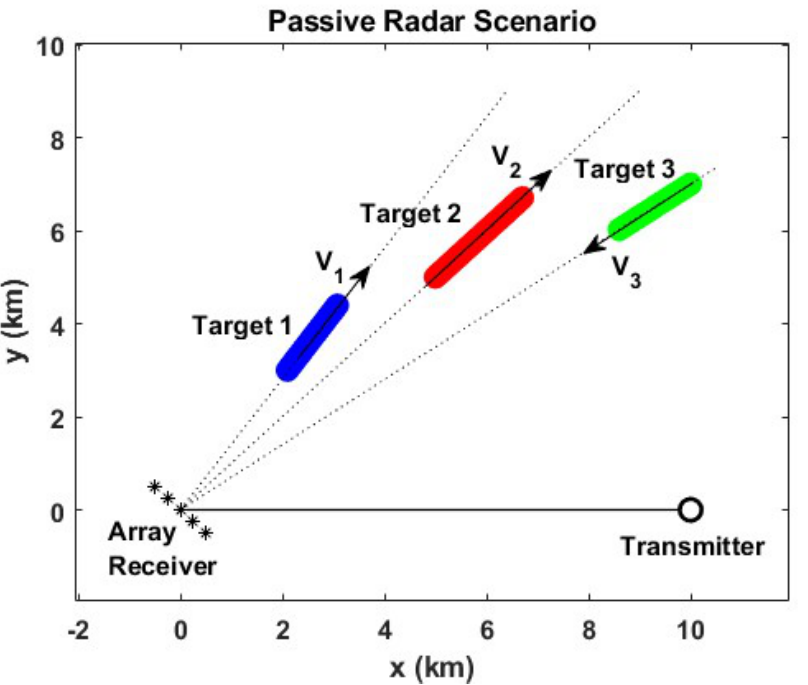
Figure 4. Synthetic passive radar scenario. The symbols ’*’ depict the position and the number of the array elements. Table 3. Summary of main transmission parameters and bistatic